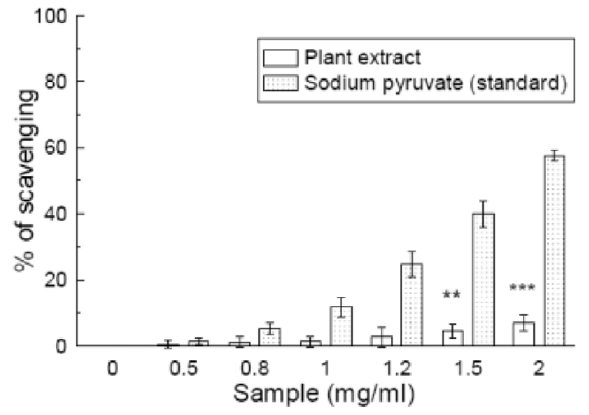
Figure 7 Singlet oxygen scavenging assay . Effects of Spondias pin- nata plant extract and the standard lipoic acid on the scav- enging of singlet oxygen. The results are mean ± S.D. of six parallel measurements. *** p < 0.001 vs 0 μ g/ml. IC = 44.74 ± 25.61 mg/ml.